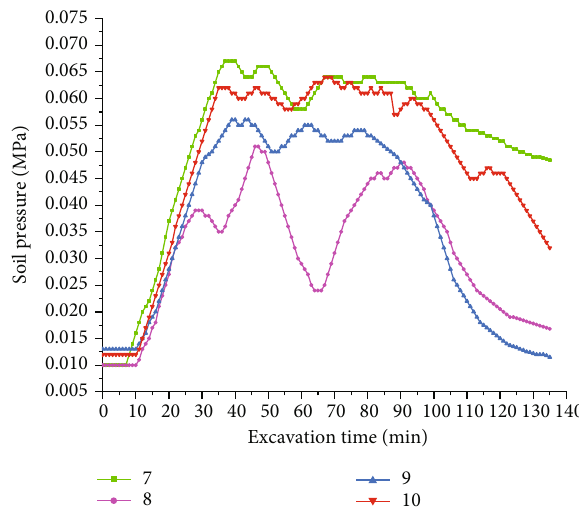
Figure 21: The changes of the soil pressure on the tunnel vault with rainfall time.